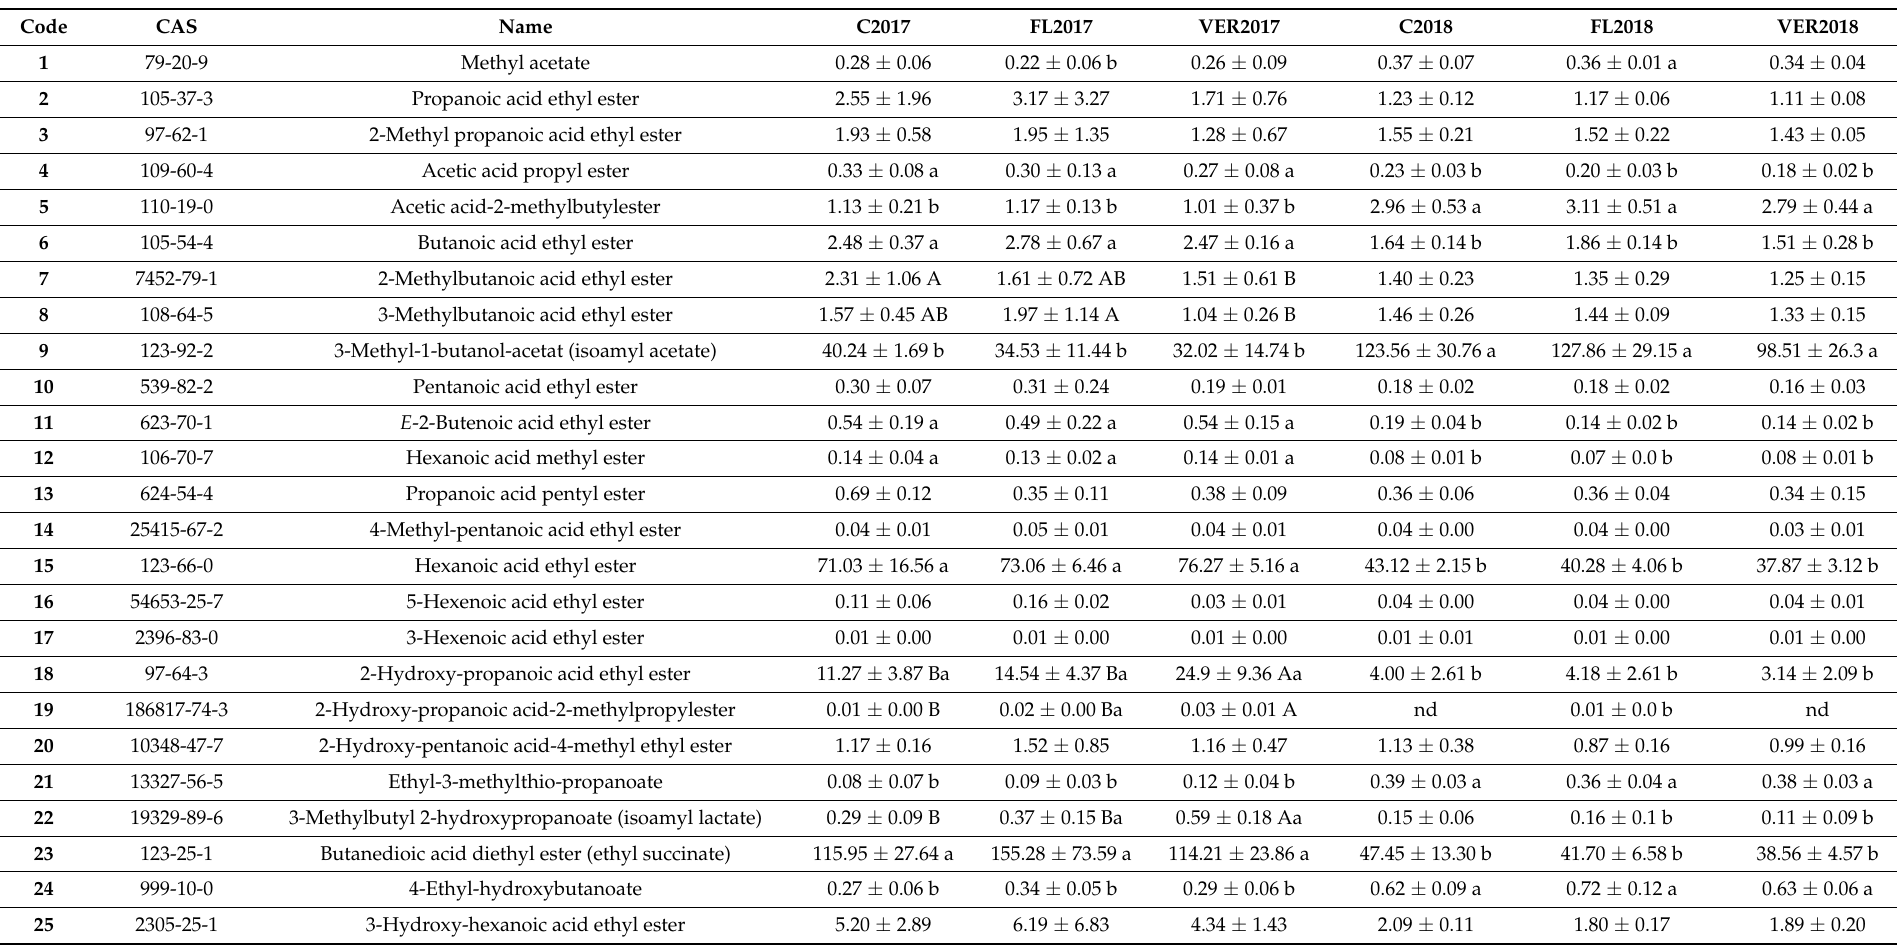
Table 2. Effects of defoliation treatments and vintage on concentrations of aliphatic esters (up to C8) ( µ g/L). (The quantification was conducted by using a linear standard calibration with acetic acid hexyl ester.) C = control; FL = removal of six leaves before flowering; VER = removal of six leaves at the end of